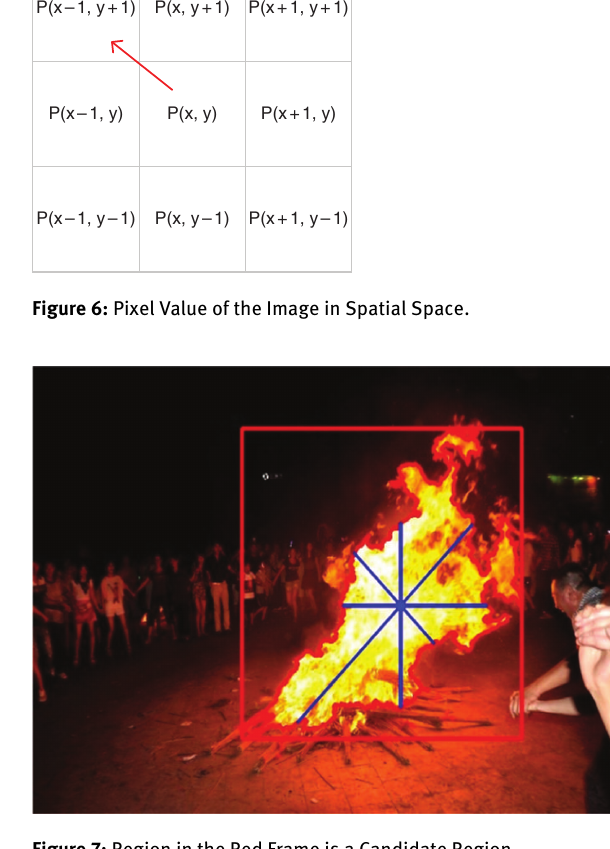
Figure 7: Region in the Red Frame is a Candidate